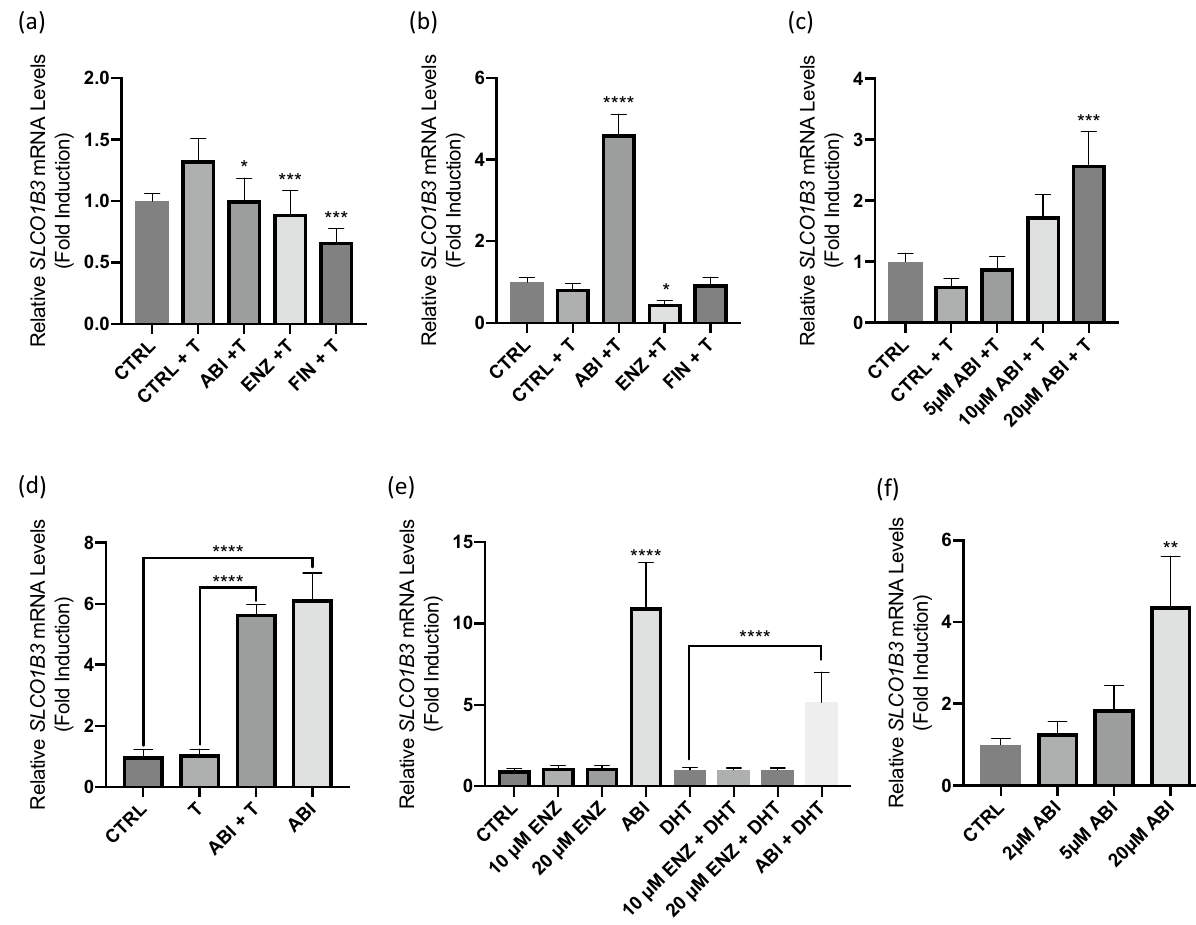
Figure 1. AR-positive prostate cancer cell lines (LNCaP, 22Rv1, and VCaP) were treated with 1 nM testosterone and three prostate cancer drugs abiraterone (ABI), enzalutamide (ENZ), or finasteride (FIN) for 24 h. RNA was extracted and assessed for changes in SLCO1B3 expression using qPCR. Gene expression was normalized to expression of β-actin. ( a ) All treatment groups produced a significant reduction in its expression at 72 h in LNCaP Cells. ( b ) Abiraterone produced a highly significant upregulation of SLCO1B3 in 22Rv1 cells. ( c ) Concentration-dependent effect of abiraterone (ABI) significantly increased the expression of SLCO1B3. 22Rv1 cells were treated in phenol red-free, charcoal-stripped media with abiraterone (ABI), enzalutamide (ENZ) in the presence or absence of ( d ) 1 nM testosterone (T) or ( e ) 1 nM dihydrotestosterone (DHT) for 24 h. 22Rv1 cells were also treated with a higher dose (20 μM) of ENZ to confirm that ENZ treatment has no effect on SLCO1B3 expression. ( f ) The AR-positive prostate cancer cell line, VCaP, was treated with abiraterone at increasing concentrations for 24 h. ABI increased SLCO1B3 in a dose-dependent manner. RNA was harvested from cells after 24 h of treatment and assessed for changes in SLCO1B3 expression using qPCR analysis. Gene expression was normalized to expression of β-actin. Treatment in AR-negative PC3 cells did not affect SLCO1B3 expression (data not shown). Statistical tests were performed against CRTL + T for A-C. These data are the result of three independent experiments. *P < 0.05, **P < 0.001, ***P < 0.0001, ****P <